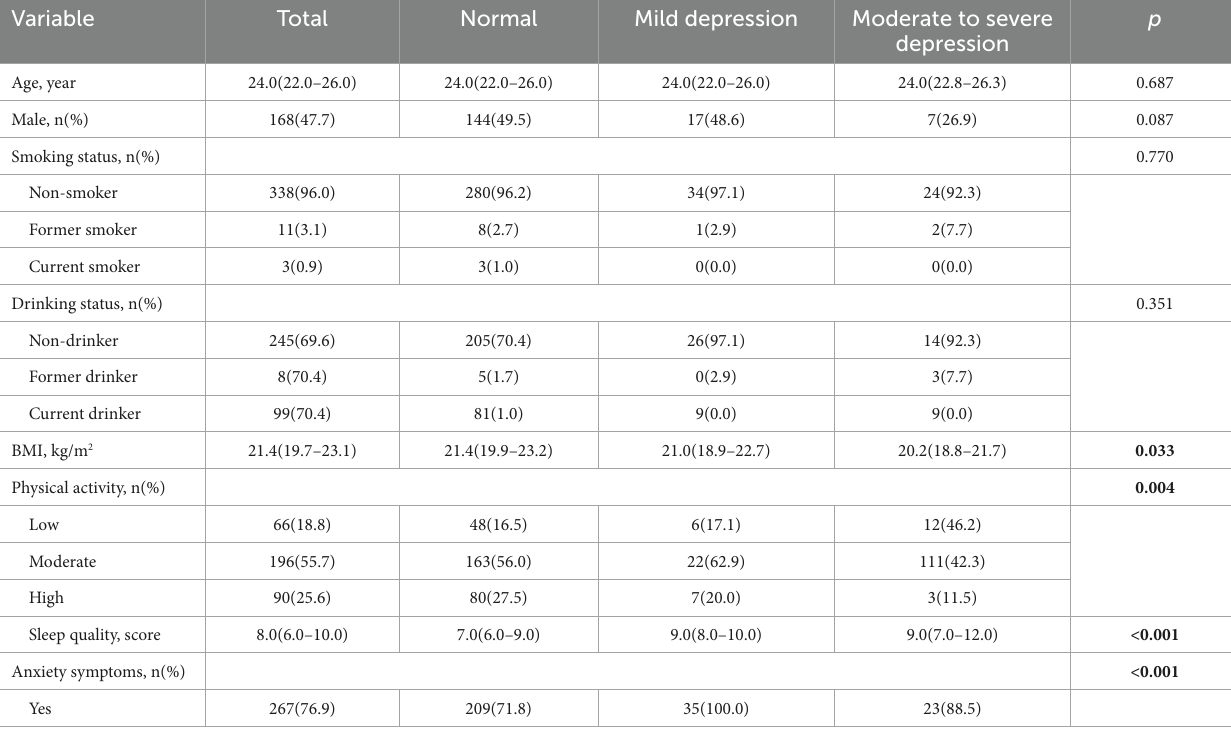
TABLE 1 Baseline characteristics of college students by level of depression.